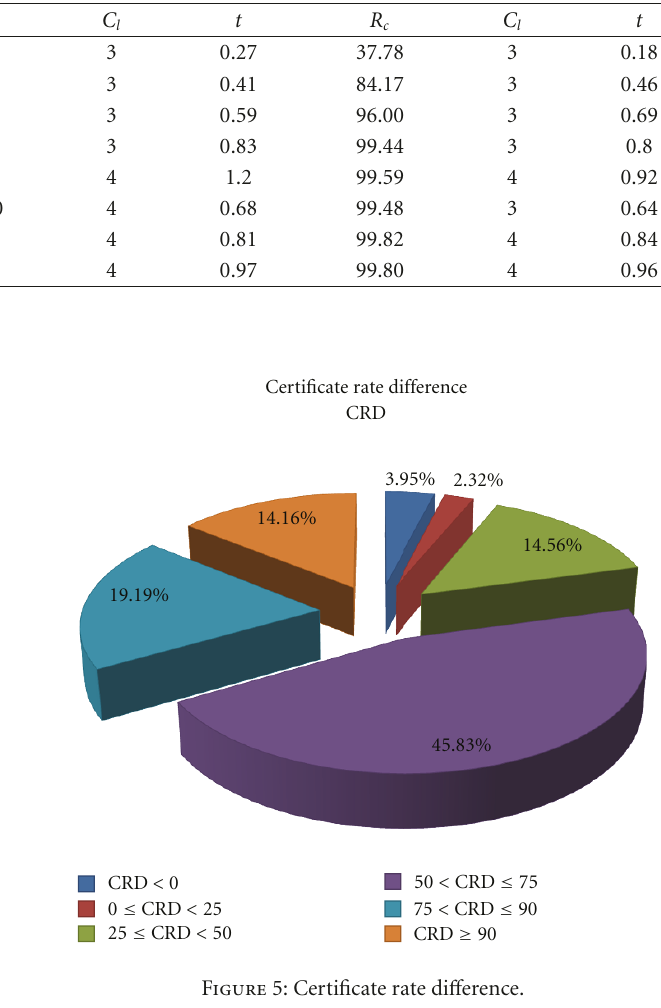
Figure 5: Certificate rate di ff